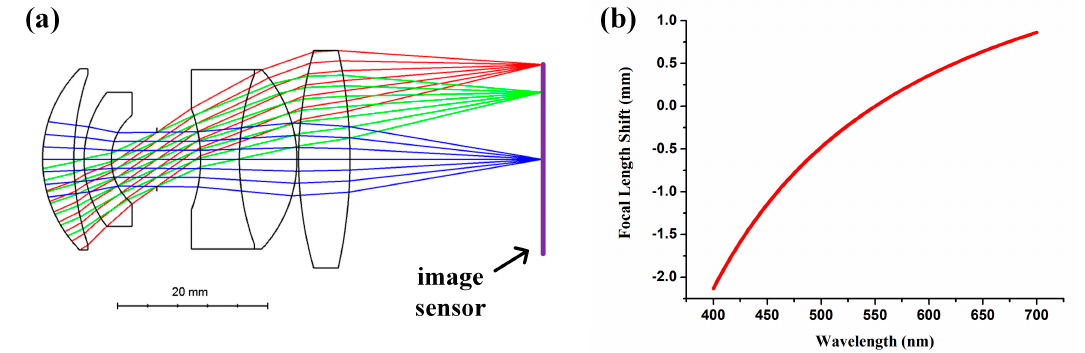
Figure 7. Chromatic camera lens and longitudinal chromatic aberration characteristics. ( a ) Optical design of chromatic camera lens by ZEMAX, longitudinal position of monochrome image sensor can be modulated by a motorized linear positioning platform. ( b ) Longitudinal chromatic aberration curve with a focal length shift range of approximately 2.99 mm in the wavelength range of 400–700 nm, focal length of 550 nm is set to 0.